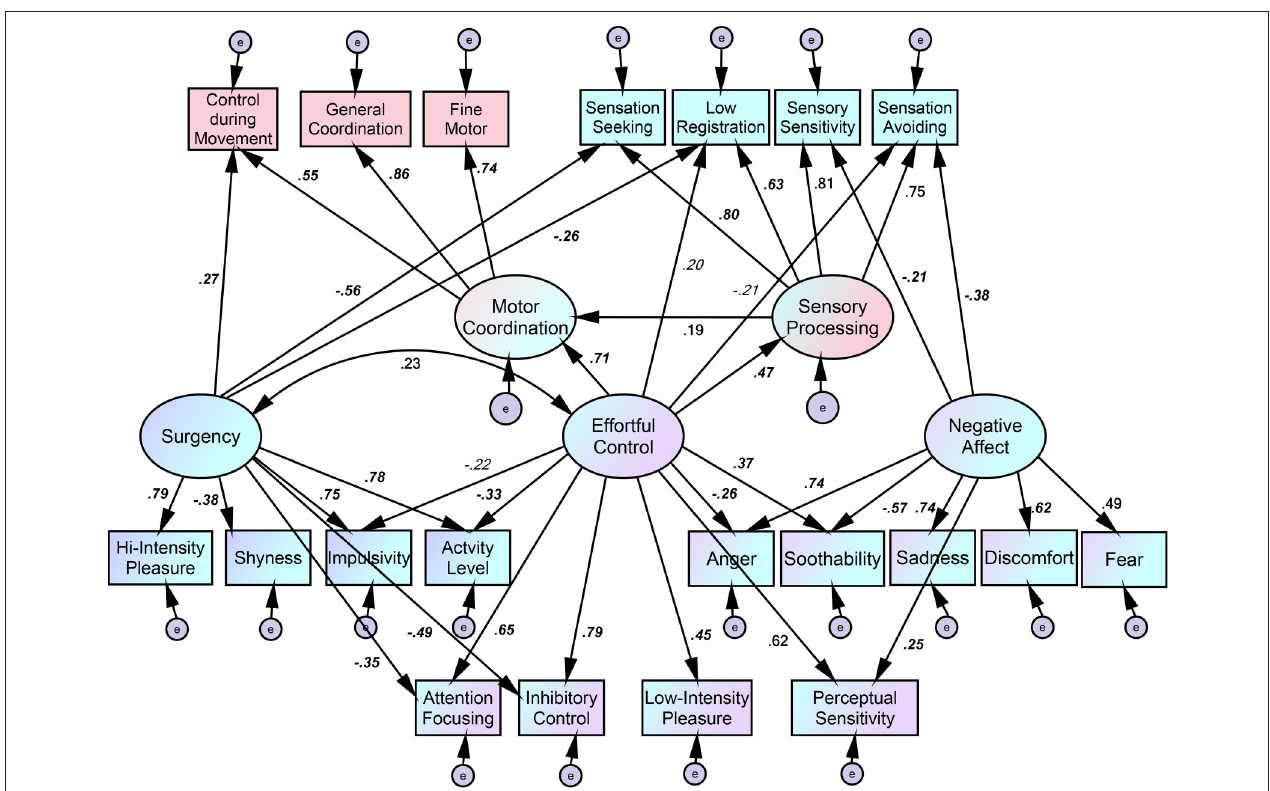
FIGURE 2 | Path diagram of causal relations between temperament, sensory processing, and motor coordination in 3-year-olds following modification indices. Italic, Bold, p < 0.001; Italic, p < 0.01; Bold, p < 0.05.